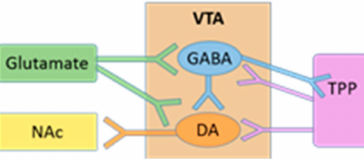
Figure 2. Schematic illustration of DA and GABA neurons in VTA and their projections to other parts of the brain. (Adopted from